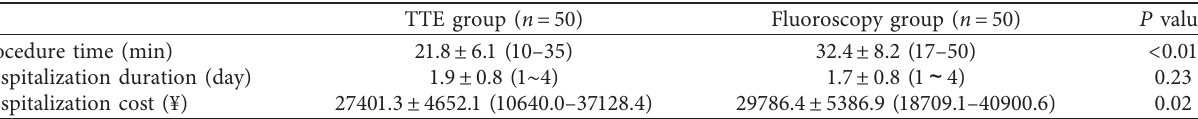
Figure 2: Trial profile. Table 2: Comparison of secondary endpoints between two